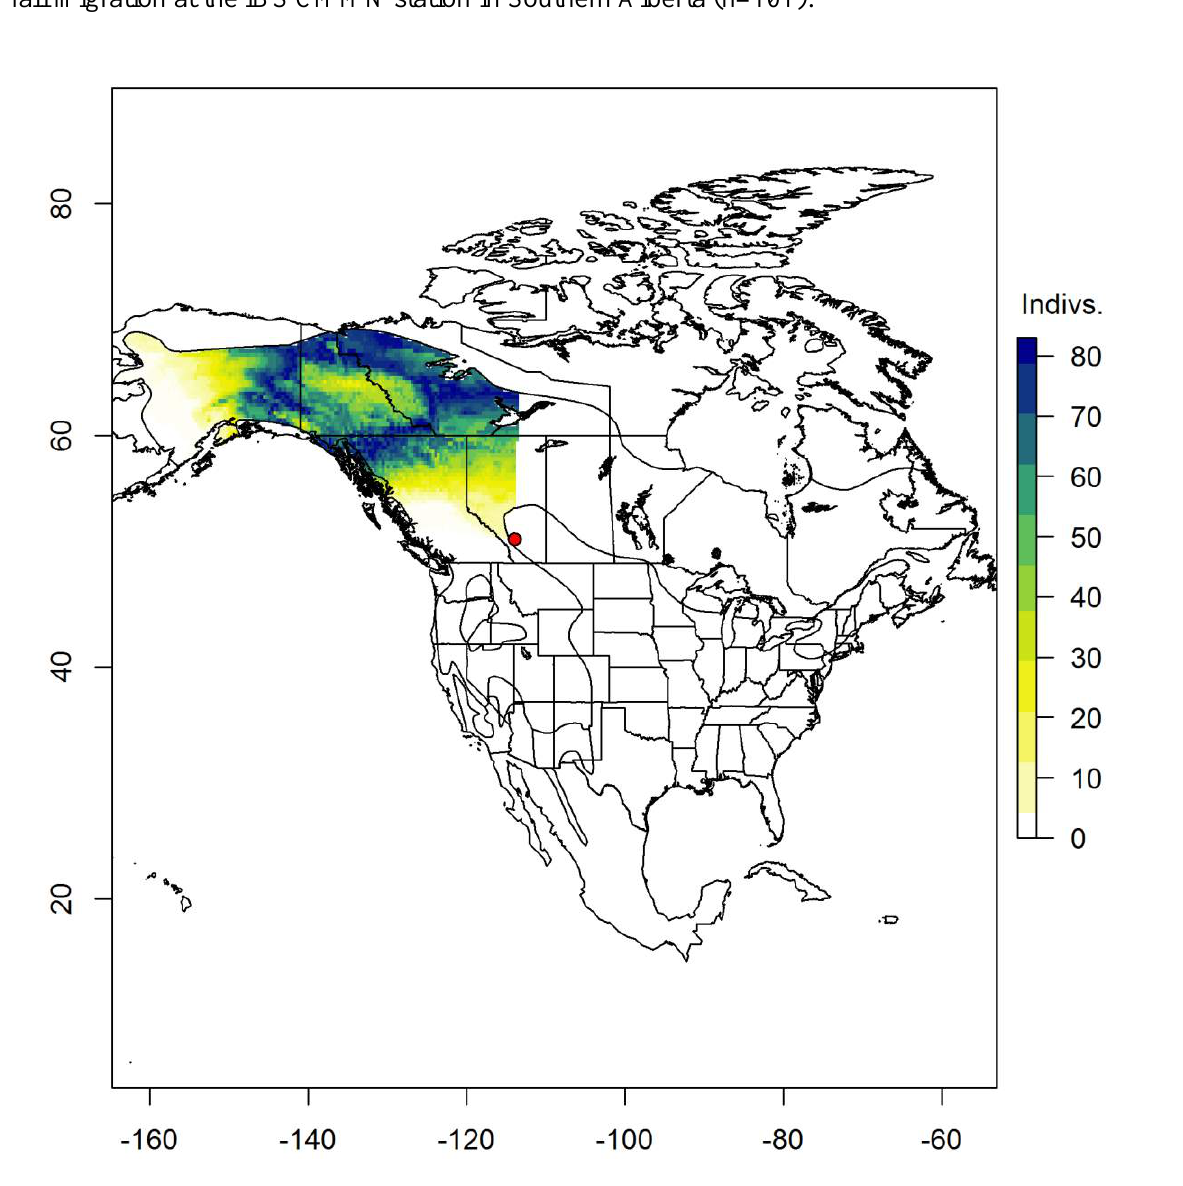
Figure A2.20: Probable origins of Yellow-rumped Warblers ( Setophaga coronata ) captured during fall migration at the IBS CMMN station in Southern Alberta